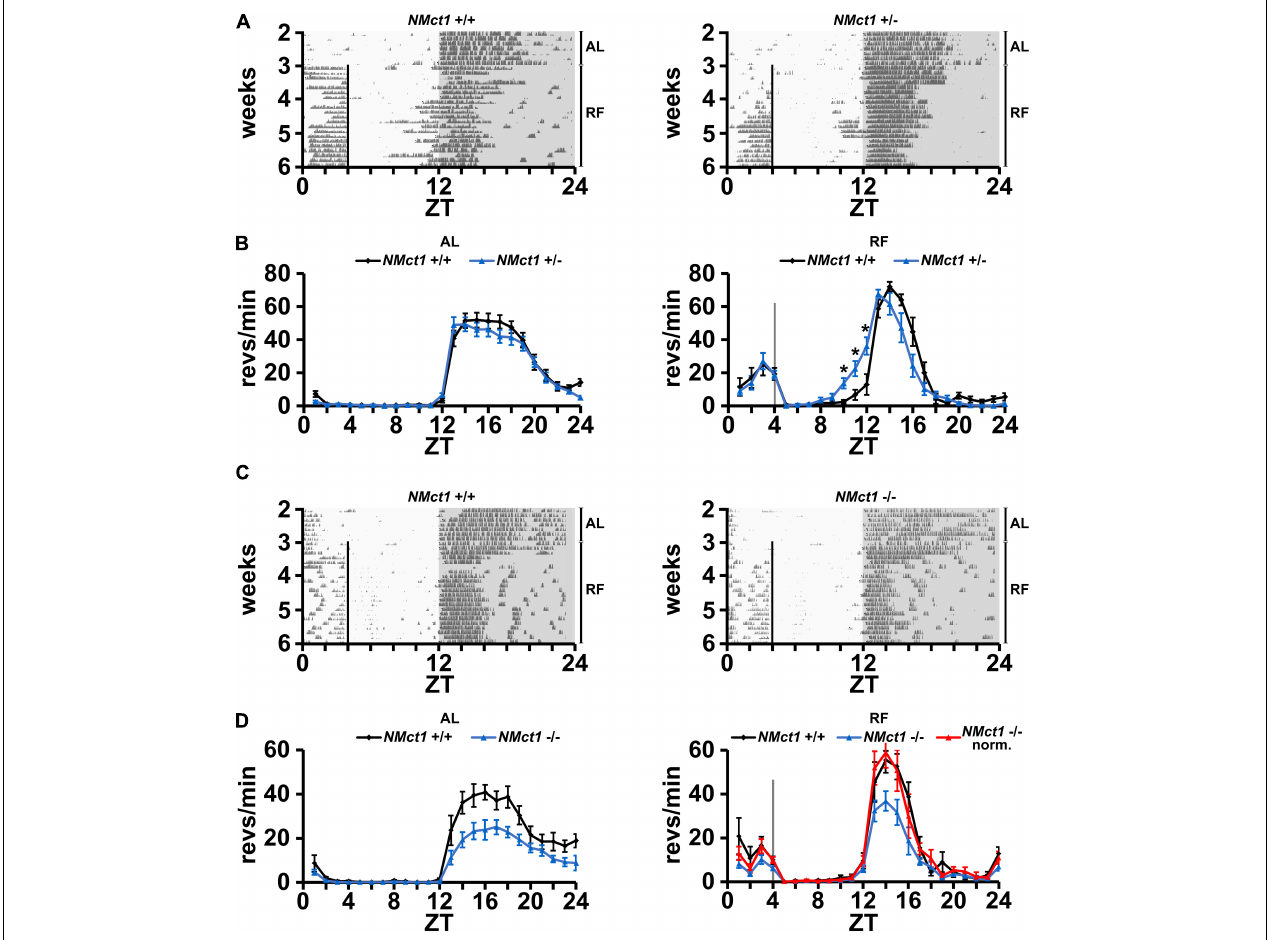
FIGURE 2 | Mice lacking Mct1 in neurons display normal FAA. (A) Examples of wheel-running actograms of neuronal Mct1 control animals ( NMct1 + / + , left panel) and heterozygous neuronal Mct1 knock-out animals ( NMct1 + / − , right panel) under ad libitum (AL) and day time restricted feeding (RF) conditions. The vertical line at ZT4 indicates the time of food access. (B) Quantified wheel-running activity plots under AL (left panel) and the last week of RF (right panel) conditions. Food anticipatory activity (FAA) under RF is normal in NMct1 + / − (blue) compared to NMct1 + / + mice (black) ( n = 8–12, 2-way ANOVA, p > 0.05). Interestingly, onset of activity in NMct1 + / − animals is significantly earlier compared to NMct1 + / + controls (* p = 0.02 at individual time-points ZT 10-1, single-point 2-tailed Student’s t -test due to non-predefined interval). (C) Examples of wheel-running actograms of neuronal Mct1 control animals ( NMct1 + / + , left panel) and homozygous neuronal Mct1 knock-out animals ( NMct1 − / − , right panel) under ad libitum (AL) and day time restricted feeding (RF) conditions. The vertical line at ZT4 indicates time of food access. (D) Quantified wheel-running activity plots under AL (left panel) and RF (right panel) conditions. Food anticipatory activity (FAA) under RF is normal in NMct1 − / − (blue) and normalized NMct1 − / − (red) compared to NMct1 + / + mice (black) ( n = 6, 2-way ANOVA, p > 0.05). Error bars represent the standard error of